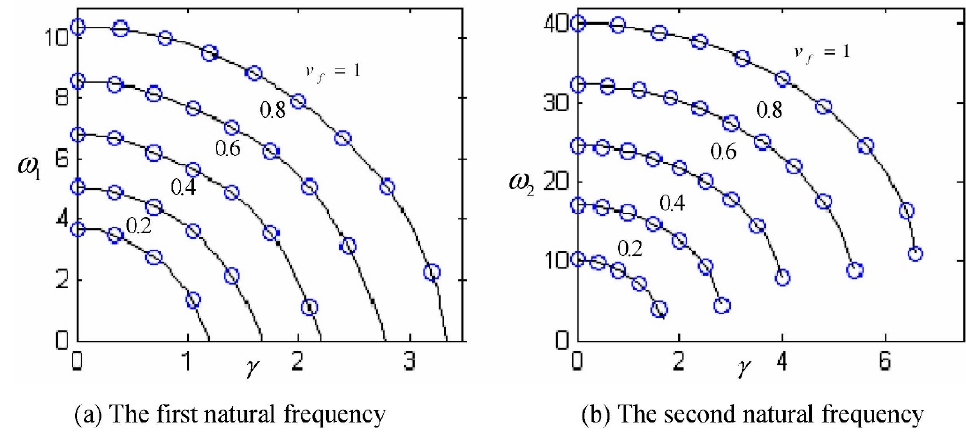
Figure 2. The subcritical natural frequencies for simple supports.